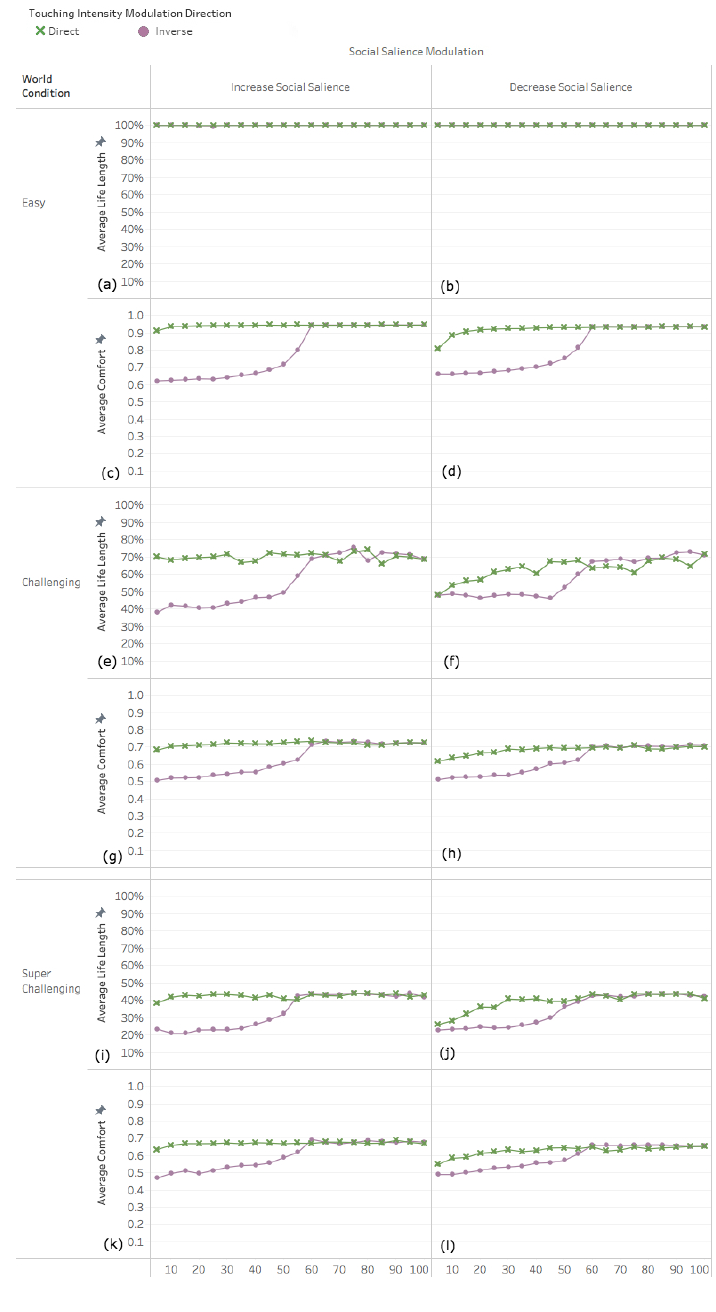
Figure 5. Summary of results for Experiment 2, showing a comparison of Average Life Length and Comfort Levels across all touchingIntensity values, split by social salience and touchingIntensity modulation direction. Increased Social Salience groups are all graphs to the left, Decreased Social Salience groups are all graphs to the right. ( a ) Average life length across Easy (E) worlds and Increased Social Salience (+). ( b ) Average life length across Easy (E) worlds and Decreased Social Salience ( − ). ( c ) Average comfort levels across Easy (E) worlds and Increased Social Salience (+). ( d ) Average comfort levels across Easy (E) worlds and Decreased Social Salience ( − ). ( e – h ) As ( a – d ), for Challenging world conditions. ( i – l ) As ( a – d ), for Super Challenging world